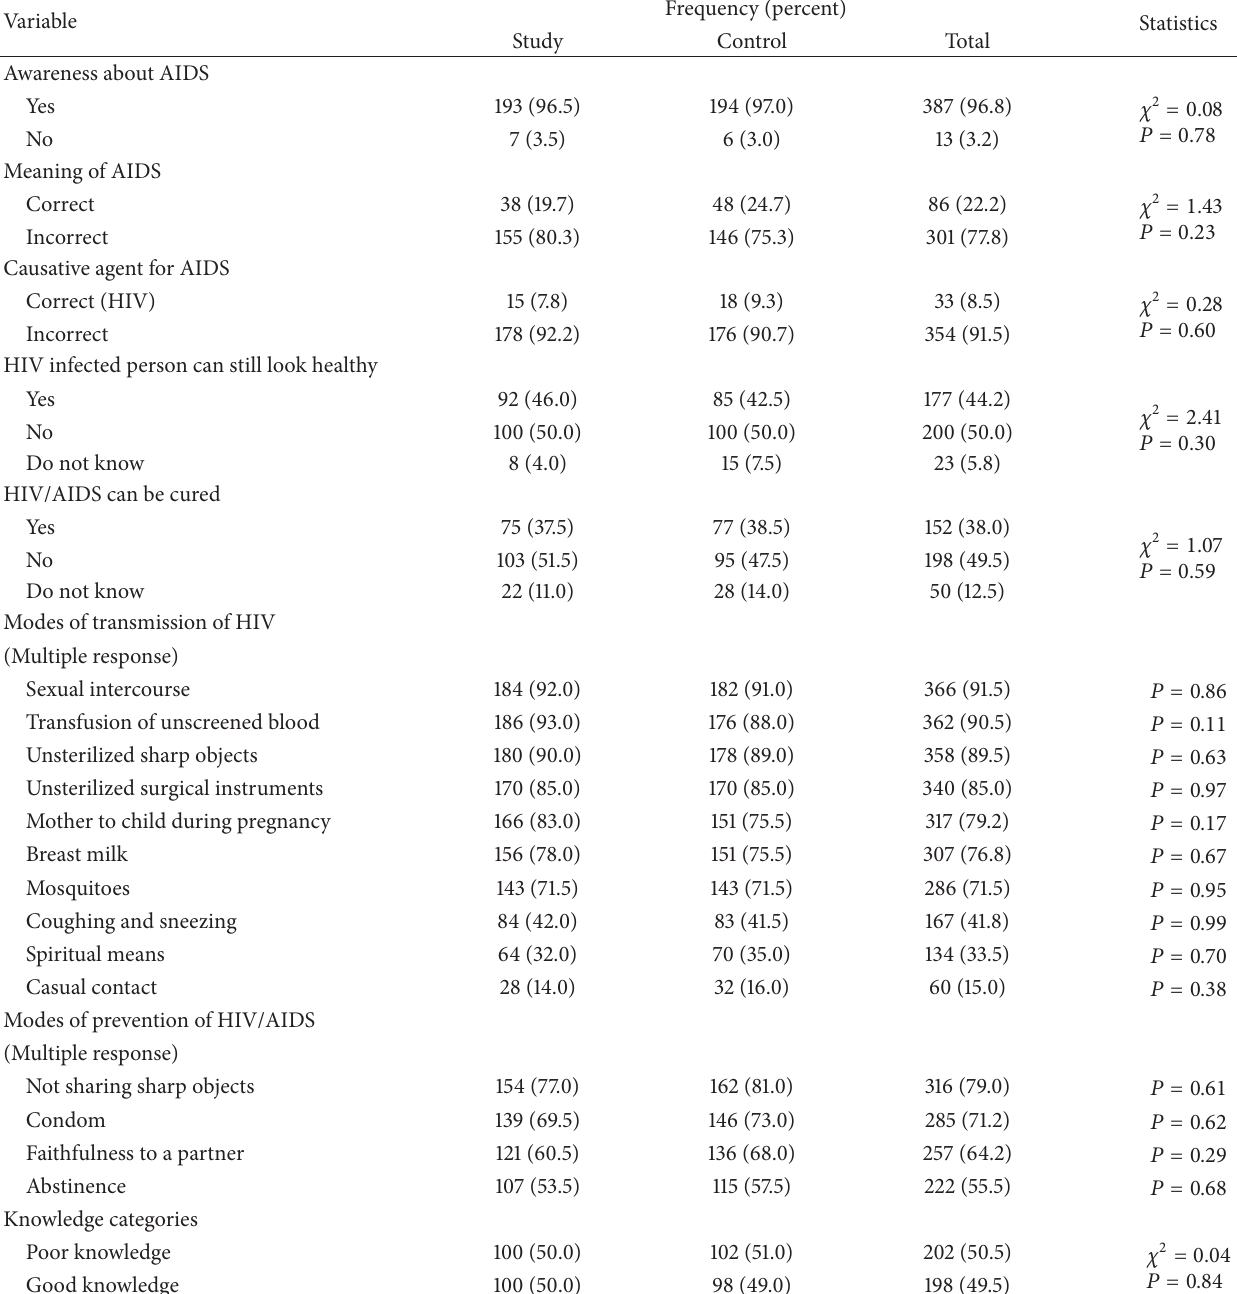
Table 2: Preinterventional knowledge of respondents about